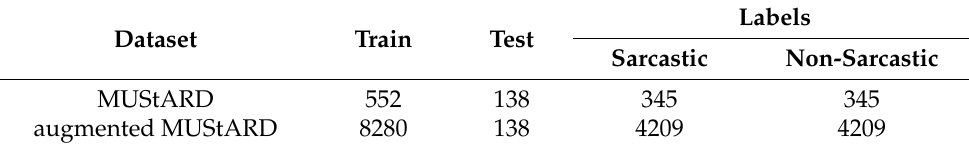
Table 1. Labels distribution in the MUStARD and augmented